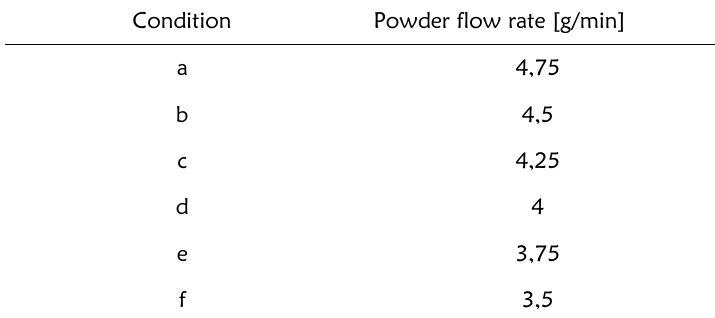
Table 3: Powder flow rates